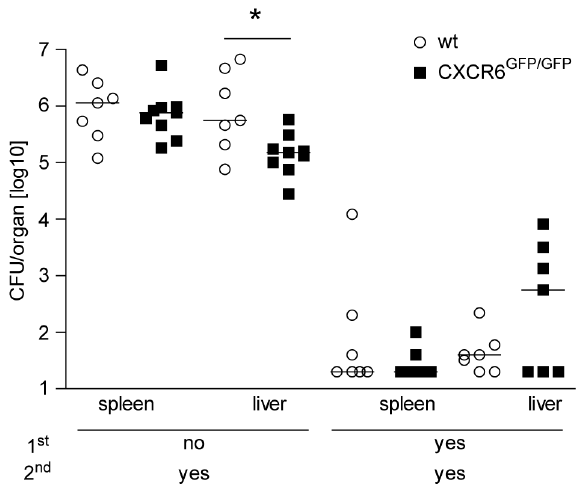
Figure 6. Control of secondary L.monocytogenes infection in CXCR6-deficient mice. Wt and CXCR6 GFP/GFP mice were primary infected with 5 6 10 3 Lm i.v. and 60 days later challenged with 1 6 10 5 Lm i.v. Two days after secondary infection, listeria titers in spleen and liver were determined. Colony forming units (CFU) for individual mice and the median of one representative experiment of two are shown, n $ 7. Detection limit was 20 CFU. *, p , 0.05.